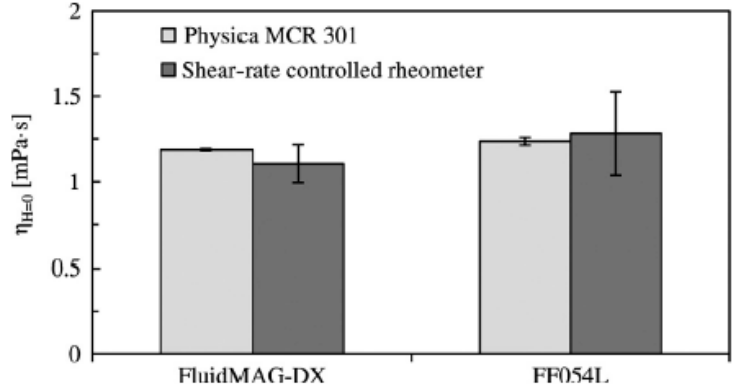
Figure 25. Newtonian viscosity of fluidMAG-DX-100 nm and FF054L samples without the influence of a magnetic field. Reprinted with permission from Reference [16].